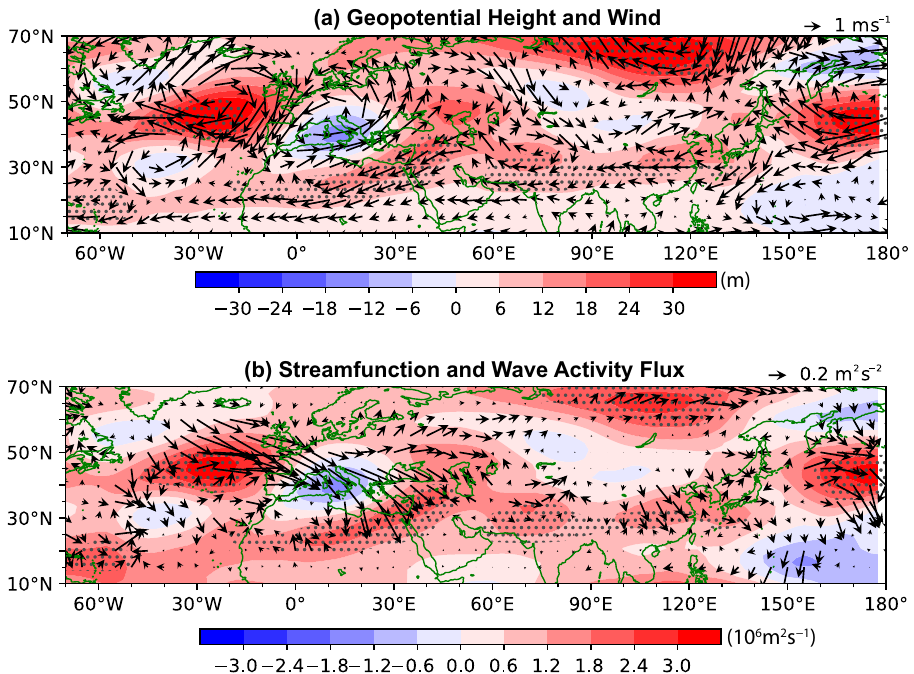
Fig. 9 Summer atmospheric changes associated with the preceding spring NAO. a Composite difference in summer geopotential height (shading) and horizontal wind (vectors) at 250 hPa between negative and positive spring NAO years (i.e., negative minus positive). b As a but for streamfunction (shading) and wave activity fl ux (vectors). Dotted area denotes signi fi cance at the 0.05